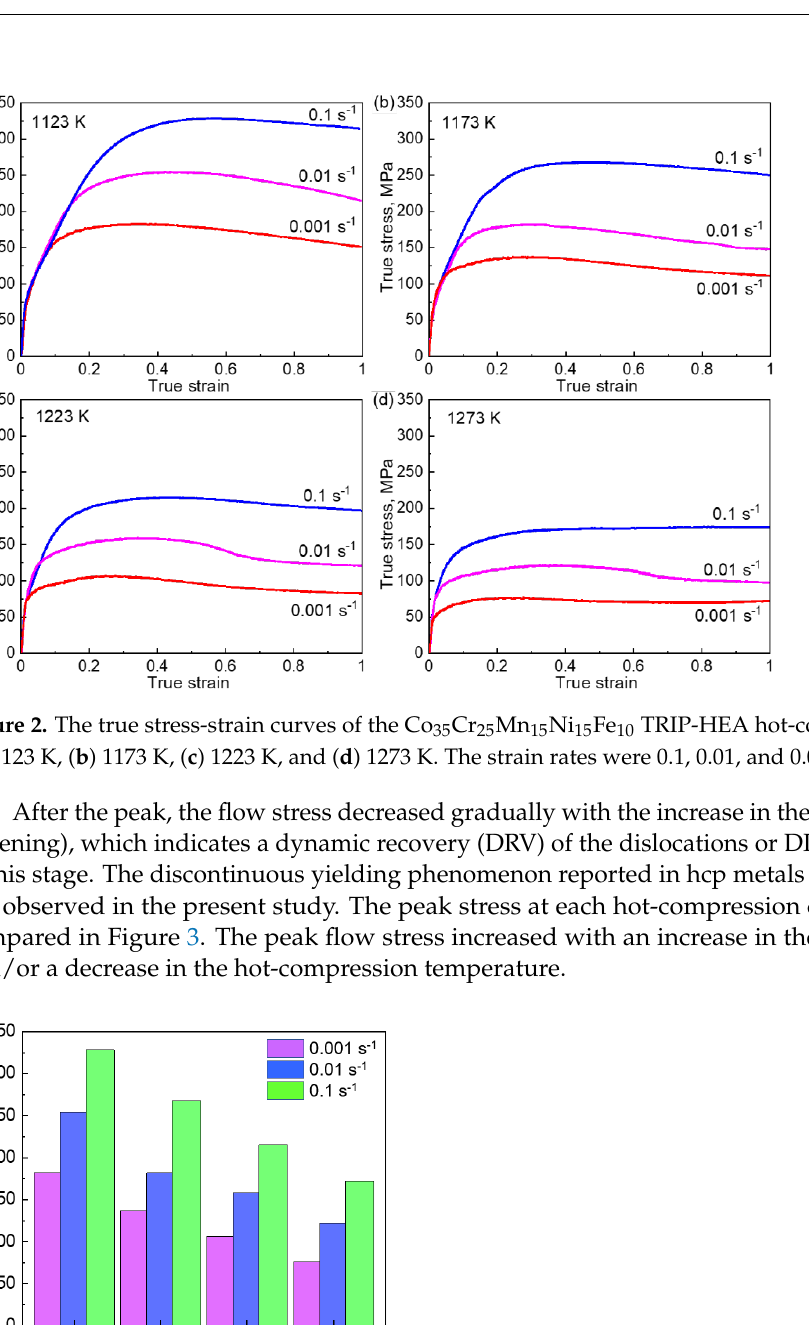
Figure 3. The peak flow stress ( σ max ) of the Co 35 Cr 25 Mn 15 Ni 15 Fe 10 TRIP-HEA hot-compressed at 1123, 1173, 1223, and 1273 K. The strain rates were 0.1, 0.01, and 0.001 s −1 .